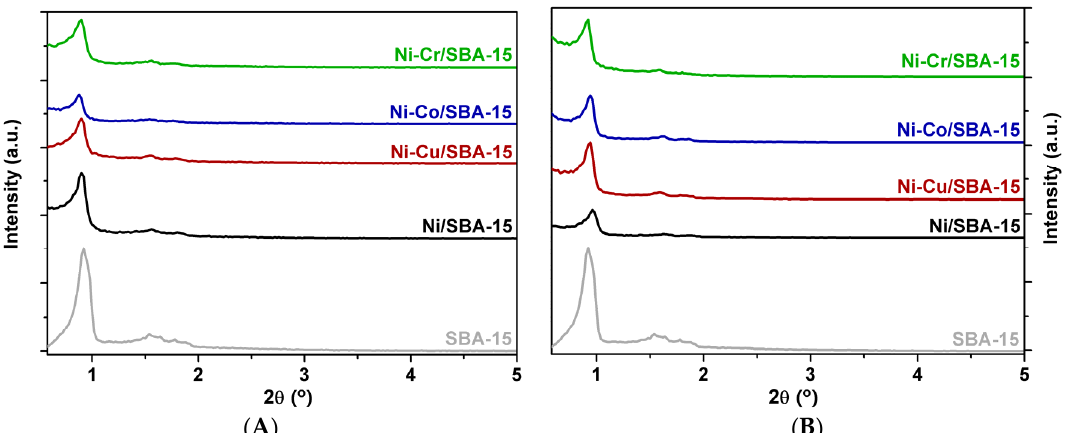
Figure 2. Small-angle X-ray diffraction of SBA-15 support and the Ni-(Cu,Co,Cr)/SBA-15 catalysts: ( A ) calcined; and ( B ) reduced.